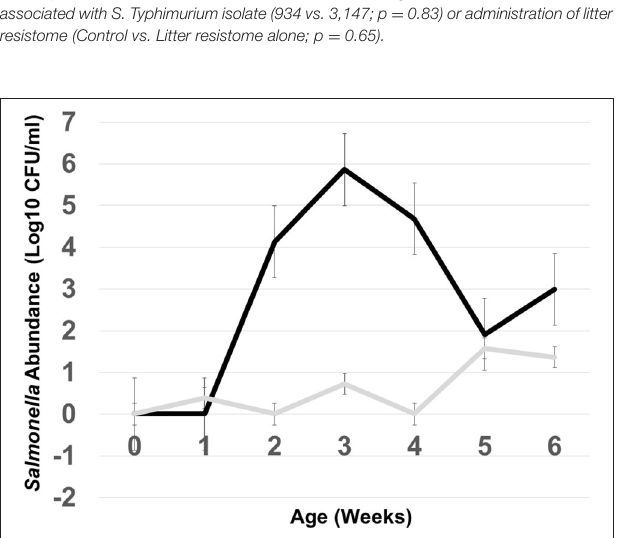
or more antibiotics was also significantly more likely in isolates from the environment of older birds (97.1% vs. 51.4%; p = 1.5 × 10 − 5